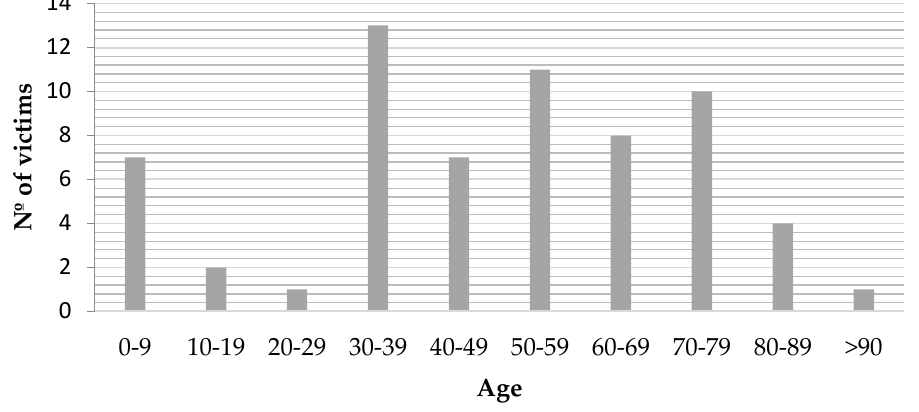
Figure 1. Distribution of the age of the dead victims-June 2017 [8].